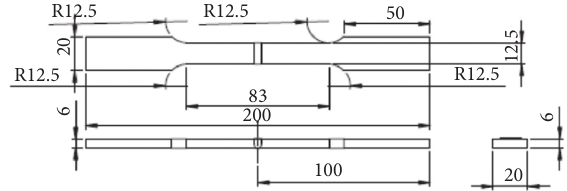
Figure 3: Test specimen for the tensile test (units in